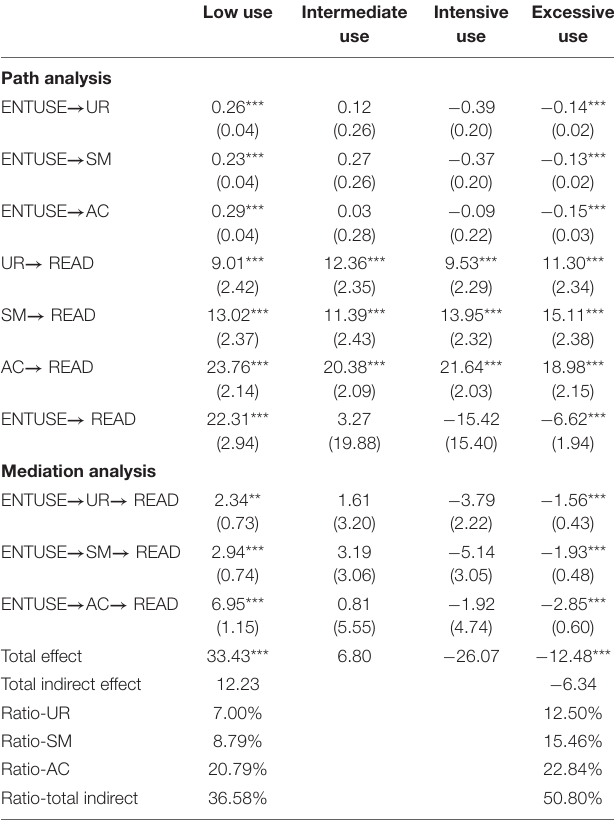
TABLE 6 | The moderated mediation analysis across ENTUSE